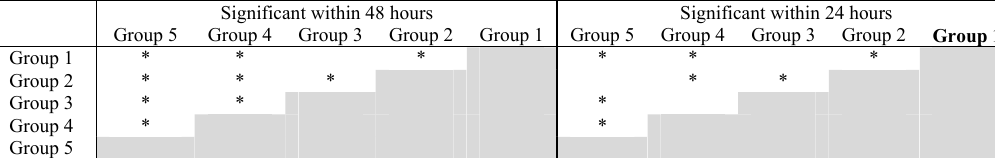
Table 8. Significance at concentration 1.75 at P<0.001 Table 8: Significance at concentration 1.75 at P<0.001